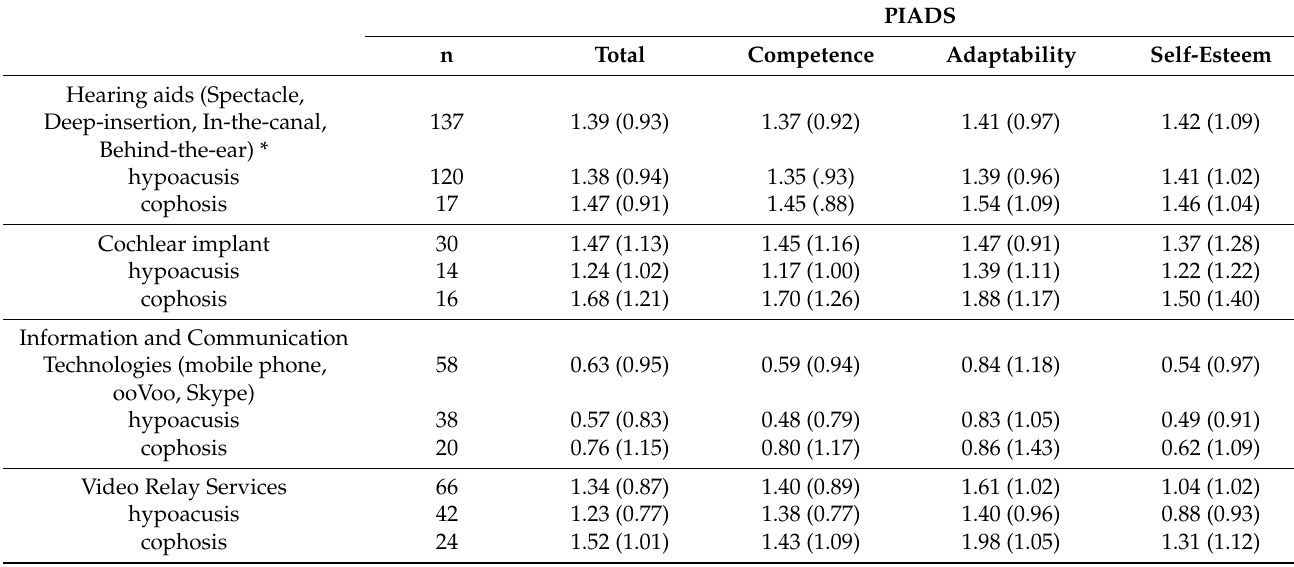
Table 2. Overall mean scores (standard deviation) for the Psychosocial Impact of Assistive Devices Scale (PIADS) and the three subscales for each type of assistive device or technology as a function of type of hearing loss. PIADS n Total Competence Adaptability